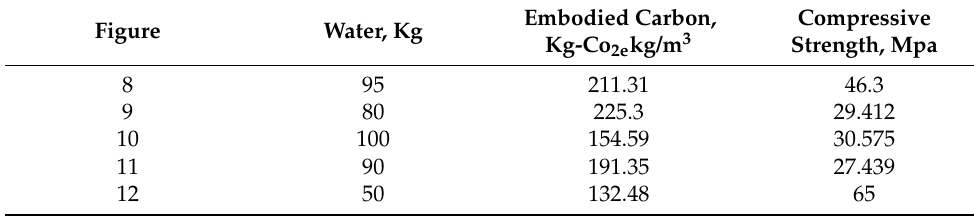
Table 19. Limiting Water in Low carbon